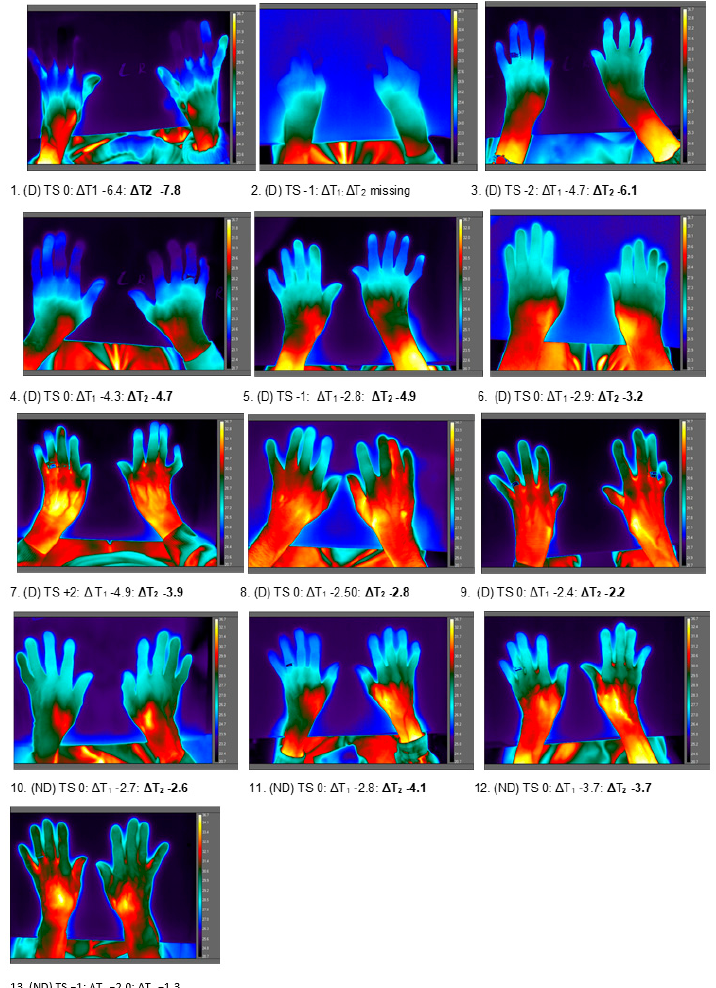
Figure 7. Thermal maps of hand and forearm of 13 residents with the visual appearance of ‘cold’ hands. Figure shows the study group; dementia (D) or no dementia (ND), thermal sensation (TS) rating and the individual temperature difference (°C) for ∆ T 1 and for ∆ T 2 .